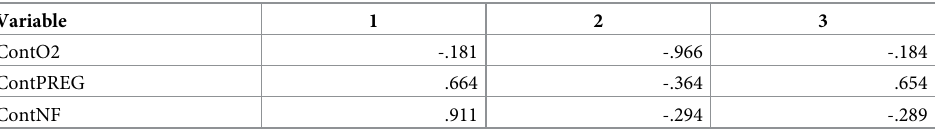
Table 12. Canonical correlation Set 1.